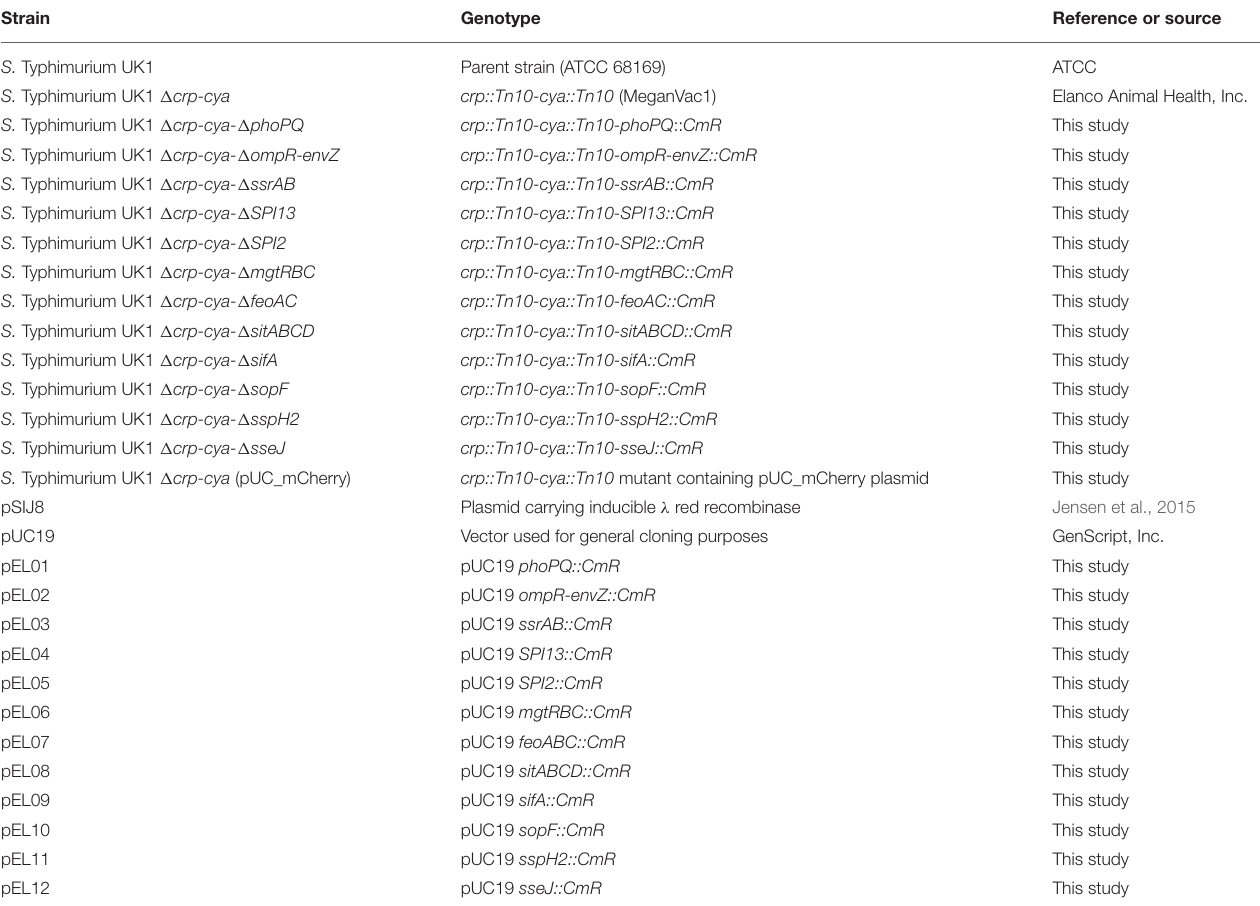
TABLE 1 | Bacterial strains and plasmids used in this study.